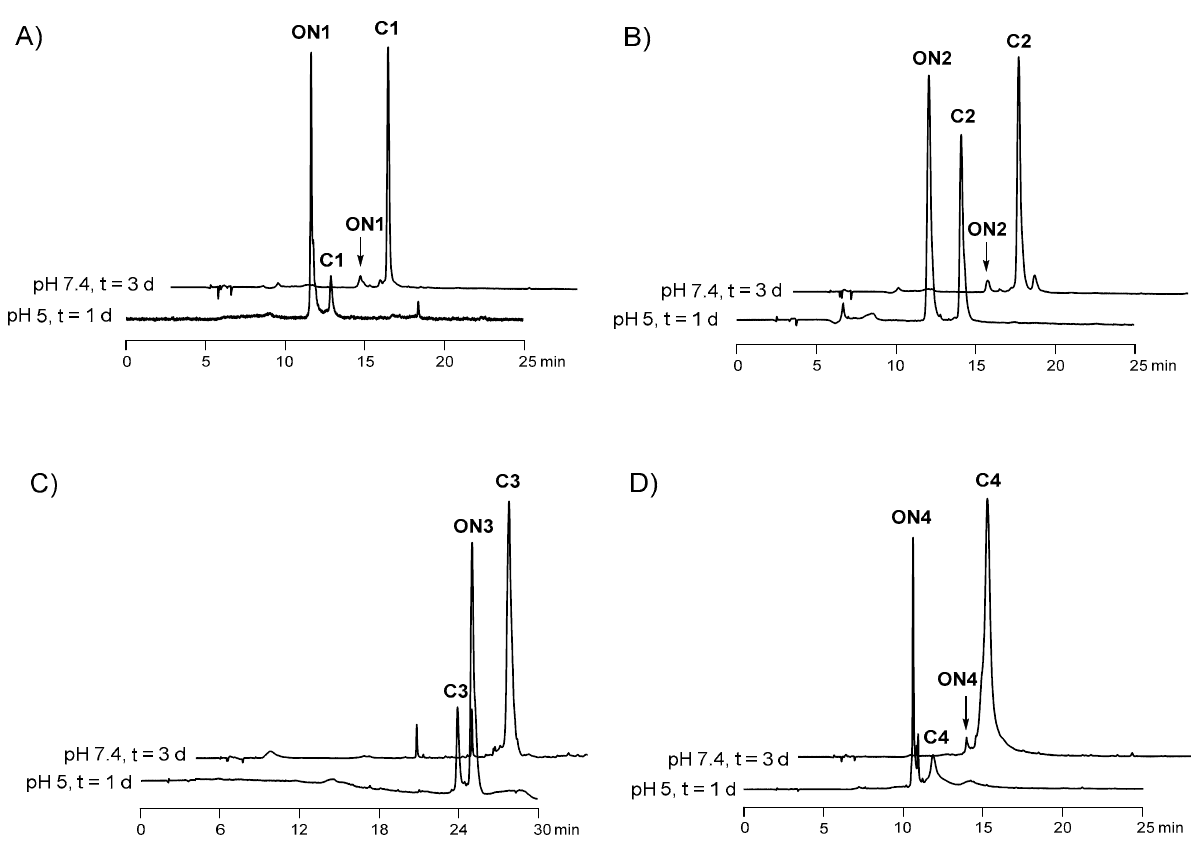
Figure 4. Selected RP HPLC (C18, 250 × 4.6 mm, 5 µm) profiles of the conjugate hydrolysis reactions. A detection wavelength of 260 nm was employed ( A ) C1 , a linear gradient of 0–60% MeCN in 25 min over aq. TEAA buffer (pH 7); ( B ) C2 , a linear gradient of 0–60% MeCN in 25 min over aq. TEAA buffer (pH 7); ( C ) C3 , a linear gradient of 0–50% MeCN in 30 min over aq. hexylammonium acetate buffer (pH 7); ( D ) C4 , 0–60% MeCN in 25 min over aq. TEAA buffer (pH 7).